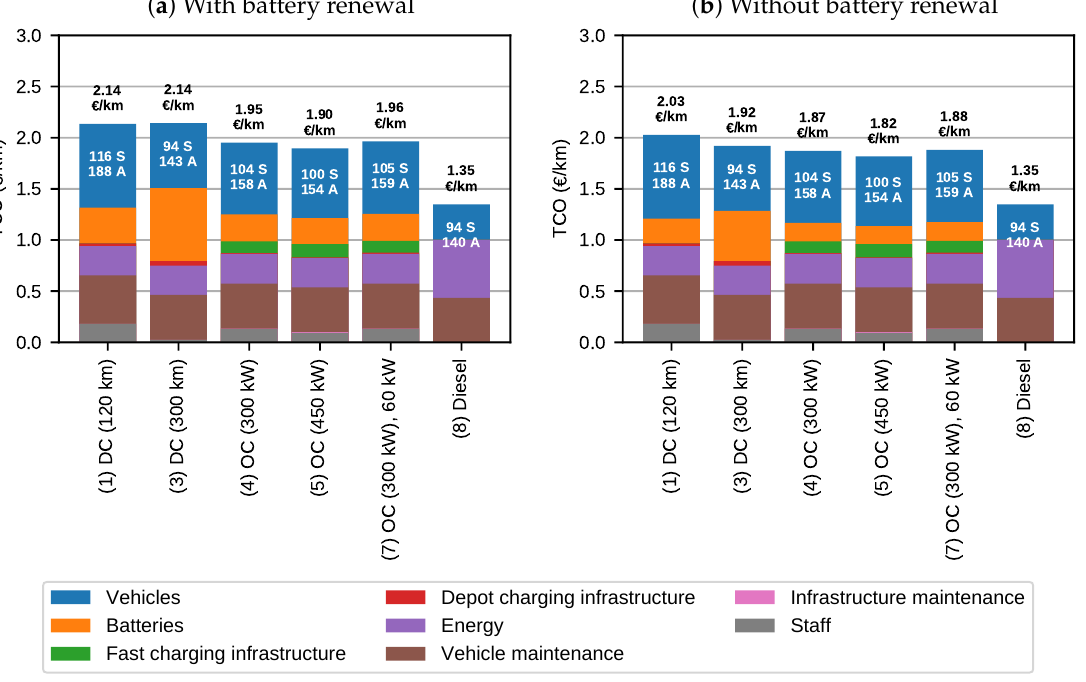
Figure 16. TCO comparison after subtracting staff cost of diesel scenario. S: standard bus; A: articulated bus. Table 9. Comparison of TCO results from the